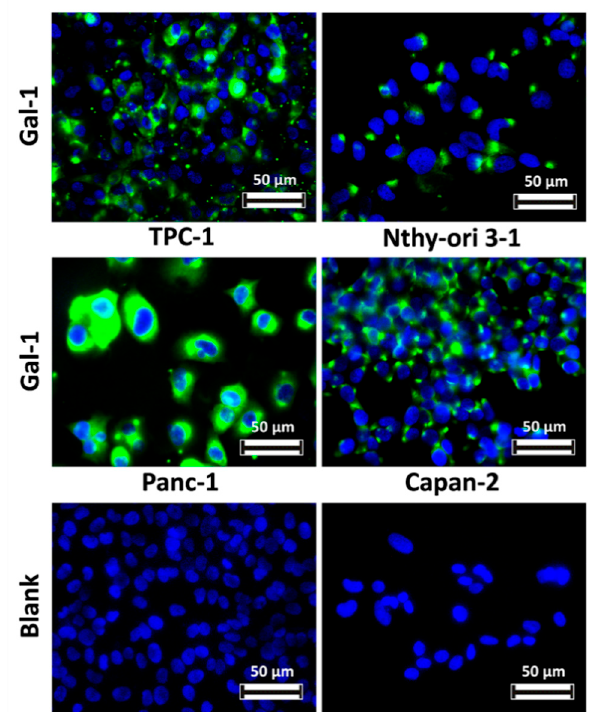
Figure 3. Comparison of gal-1 expression within various human cell lines. Gal-1 was detected with an anti-gal-1 antibody and revealed using the anti-rabbit antibody conjugated to Dylight 488 (green). Nuclei are stained in blue with 4 ′ ,6-diamidino-2-phenylindole (DAPI). Two types of xenografts were considered: an orthotopic one at the neck level and an ectopic subcutaneous one at the thigh level. The absence of trachea obstruction by orthotopic tumors was confirmed by